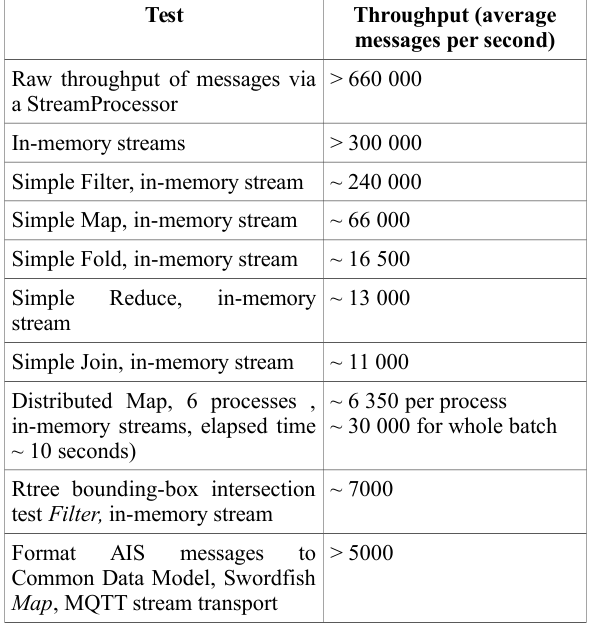
Table 5: Indicative performance